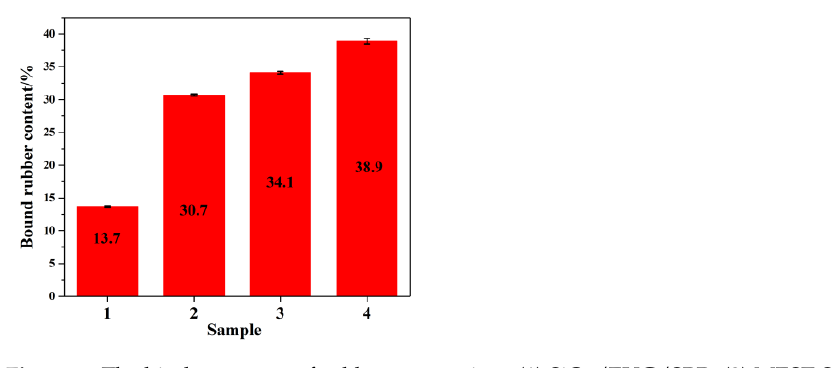
Figure 6. The binder content of rubber composites: (1) SiO 2 /EUG/SBR; (2) MEST-SiO 2 /EUG/SBR; (3) SiO 2 /EEUG/EUG/SBR; (4) MTES-SiO 2 /EEUG/EUG/SBR.